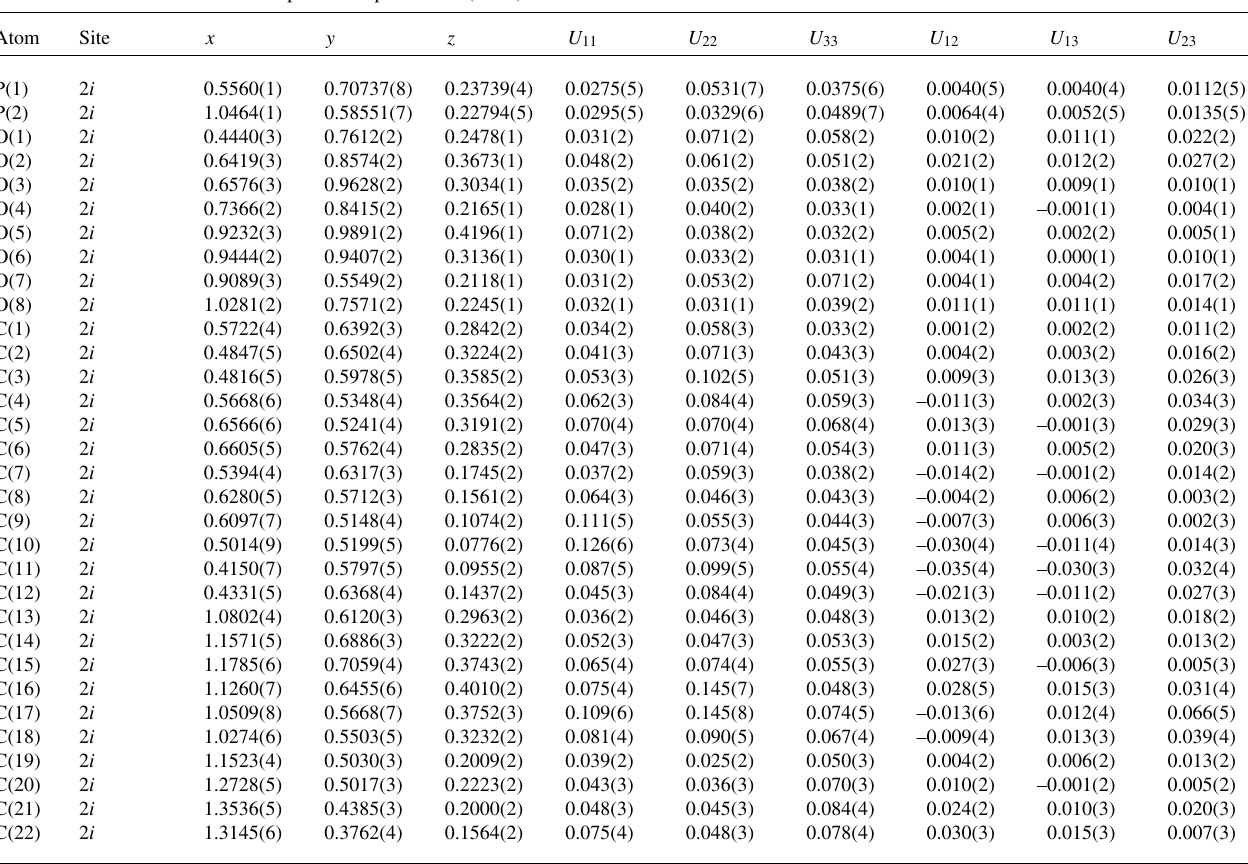
Table 3. Atomic coordinates and displacement parameters (in Å 2 )